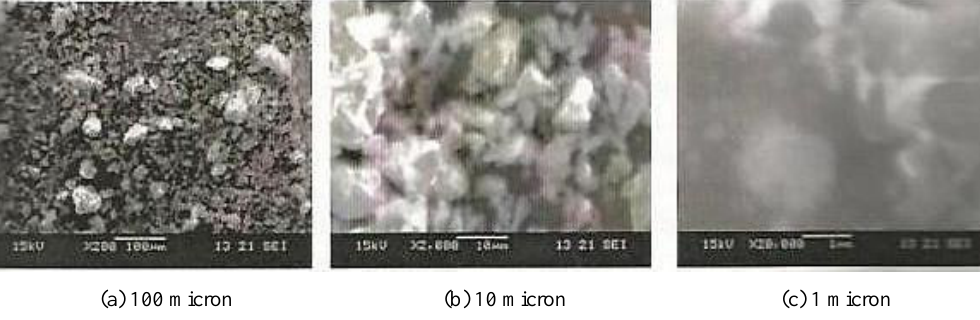
Figure 6. SEM Analysis for various materials ( OPC-43 ).